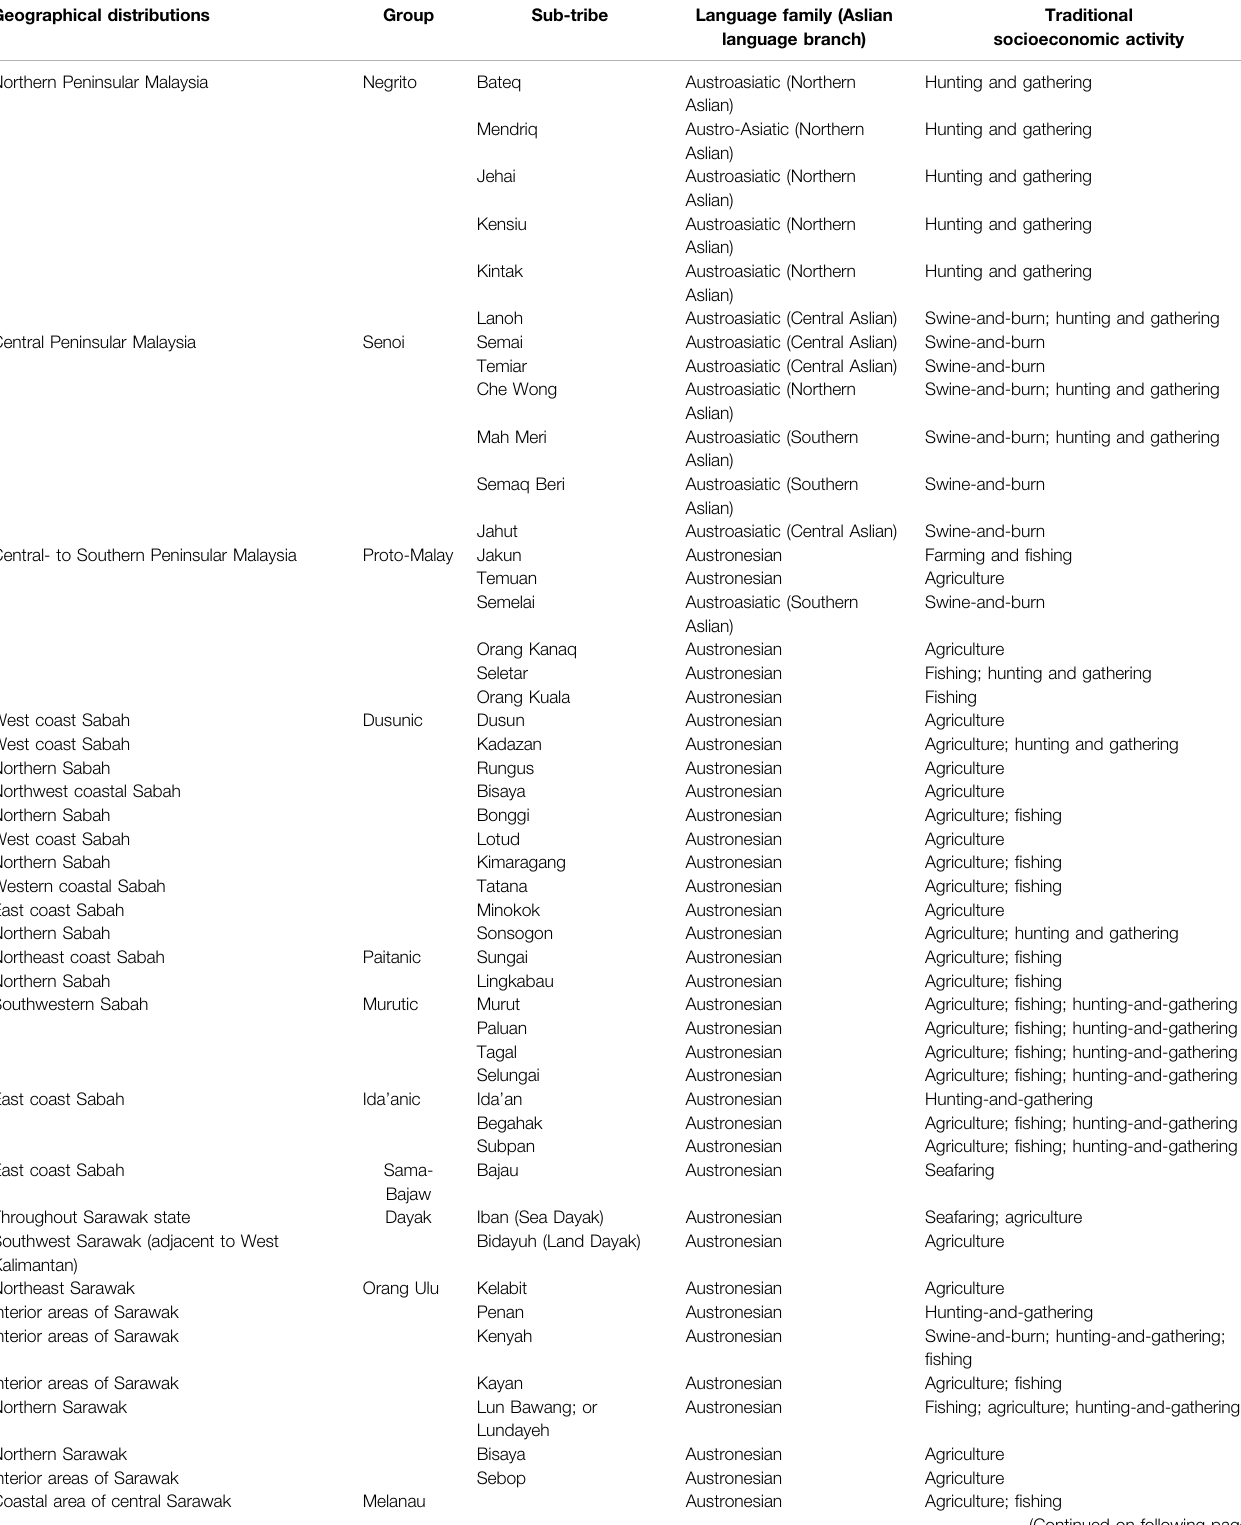
TABLE1| Classi fi cationofOrangAsliandsomemajorsub-ethnicpopulationsfromBorneo.EachOrangAsligroupisfurtherdividedintosixsub-tribes.ThenativesSabahan are primarily classi fi ed into fi ve language groups (Dusunic, Paitanic, Murutic, Ida ’ anic, and Sama-Bajaw). The major Sarawak natives include the two major communities namely, the Dayaks and the Orang